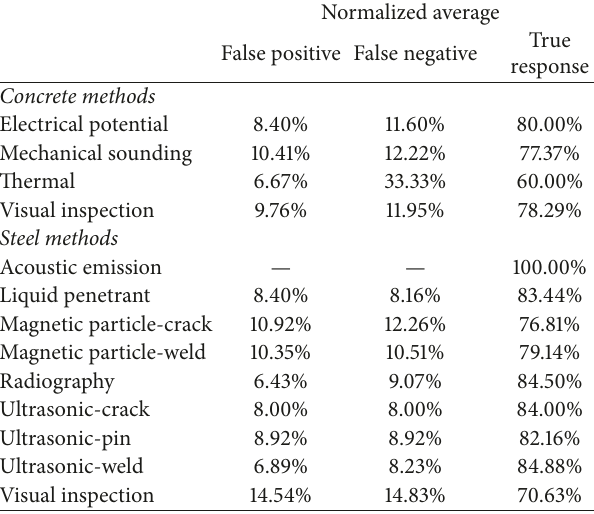
Table 5: Concrete and steel NDE method normalized averages for accuracy determined from the participant